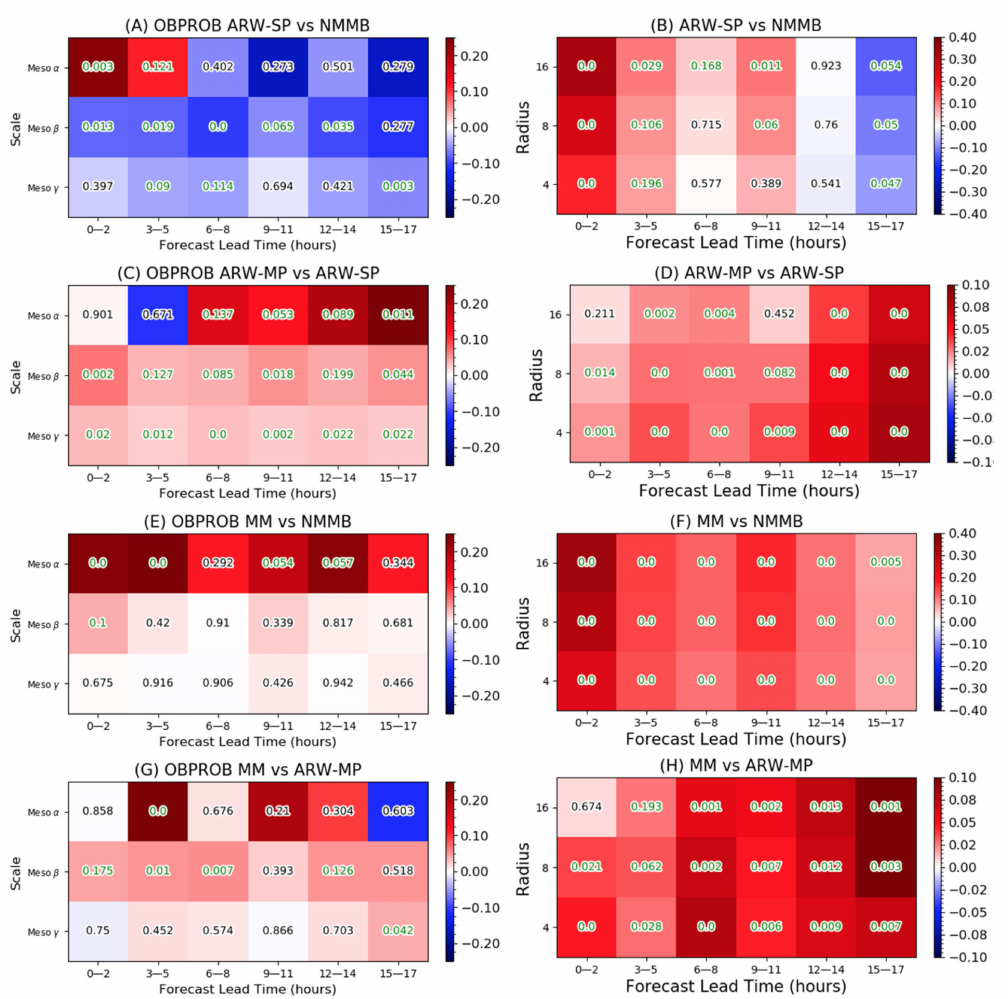
Figure 6. Left column: Object-based Brier score averaged difference over all cases based on lead time and binned every three forecast hours for ( A ) SP vs. NMMB, ( C ) MP vs. SP, ( E ) MM vs. NMMB, and ( G ) MM vs. MP. Values shown are subtracted where red indicates added skill and blue indicates negative respective skill for the first ensemble listed in the title. Overlay p -value colors indicate the presence of statistical significance (green) at the 80% confidence level. Right column: Same as the left column except for neighborhood-based results for ( B ) SP vs. NMMB, ( D ) MP vs. SP, ( F ) MM vs. NMMB, and ( H ) MM vs. MP. Meso-alpha, beta, and gamma correspond to a radius of 16, 8, and 4,